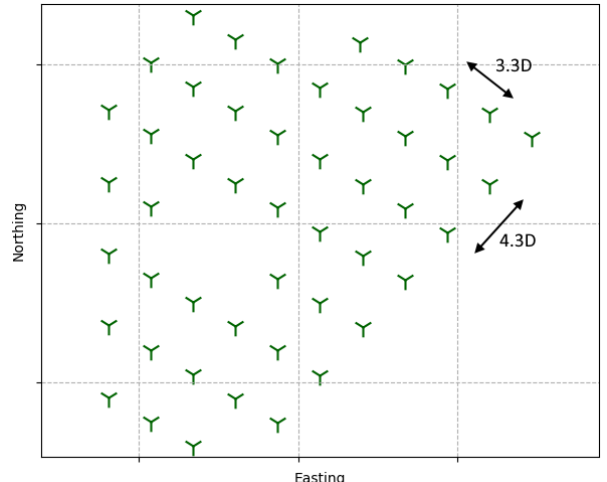
Figure 3. Layout of the Lillgrund wind farm. The turbine rotor di- ameter is 93m with a hub height of 68m. The turbine spacing is approximately 4.3D, along the south-west to north-east rows, and 3.3D along the south-east to north-west